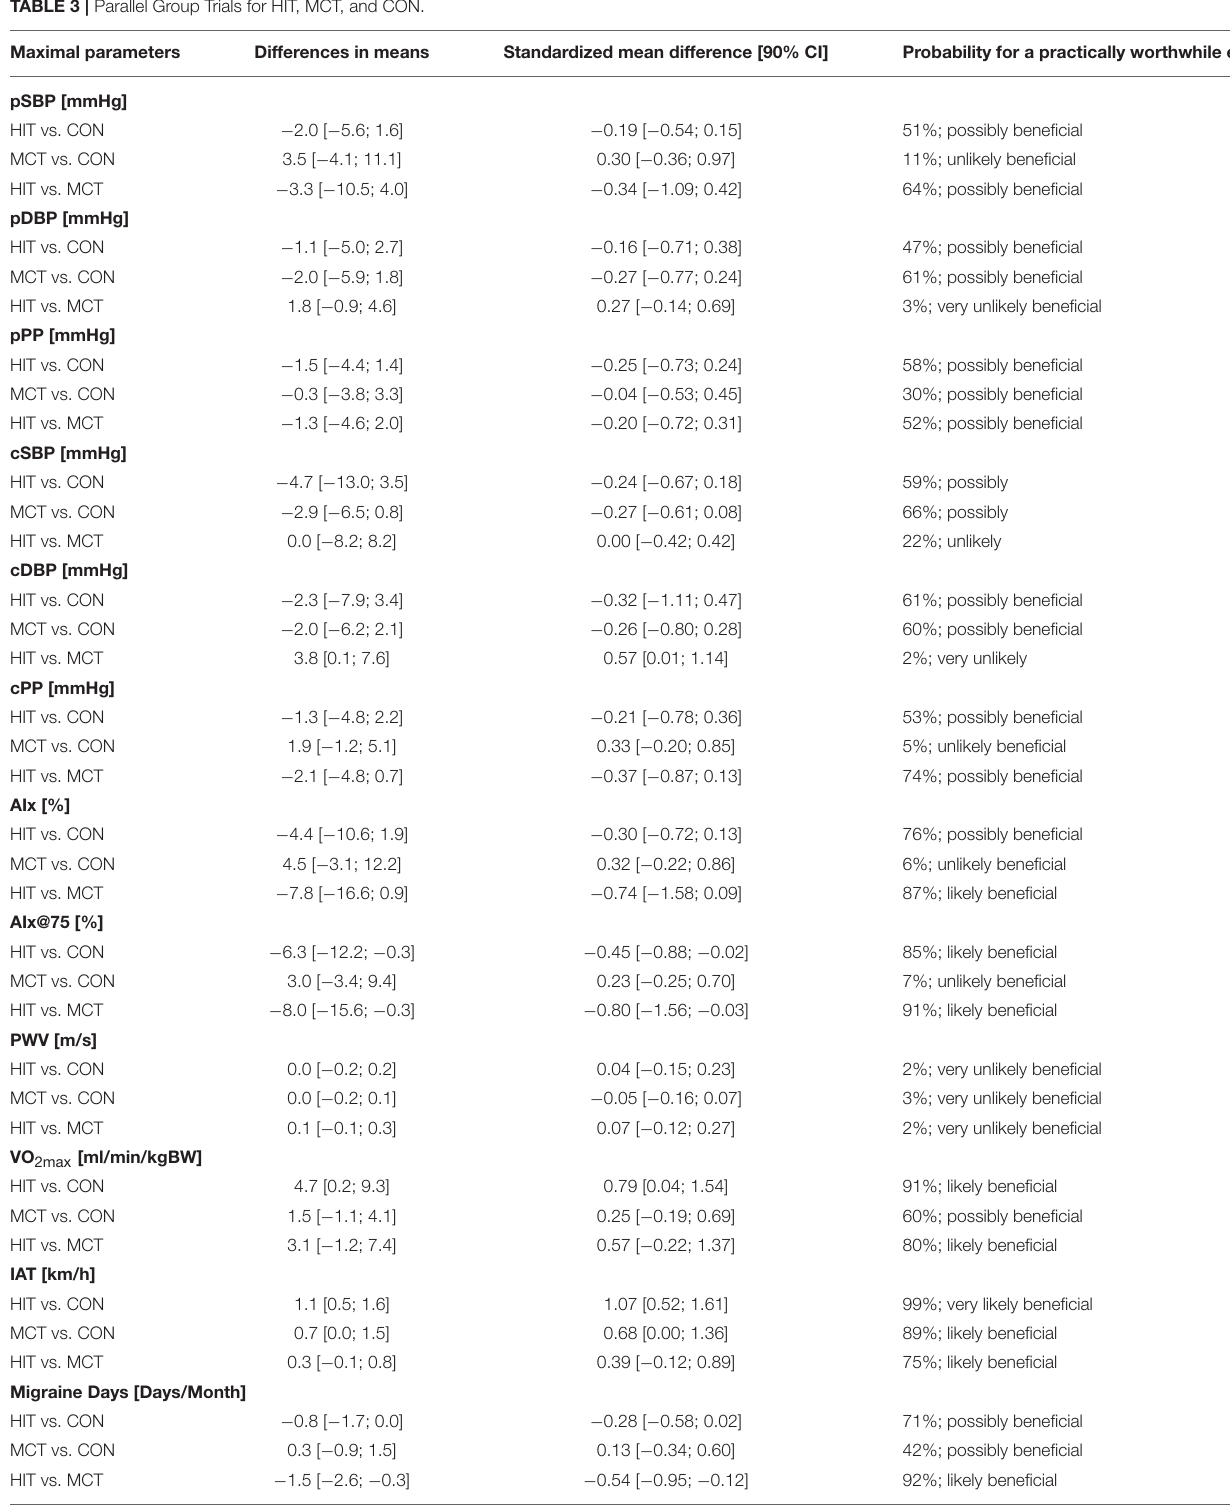
TABLE 3 | Parallel Group Trials for HIT, MCT, and CON. Maximal parameters Differences in means Standardized mean difference [90% CI] Probability for a practically worthwhile